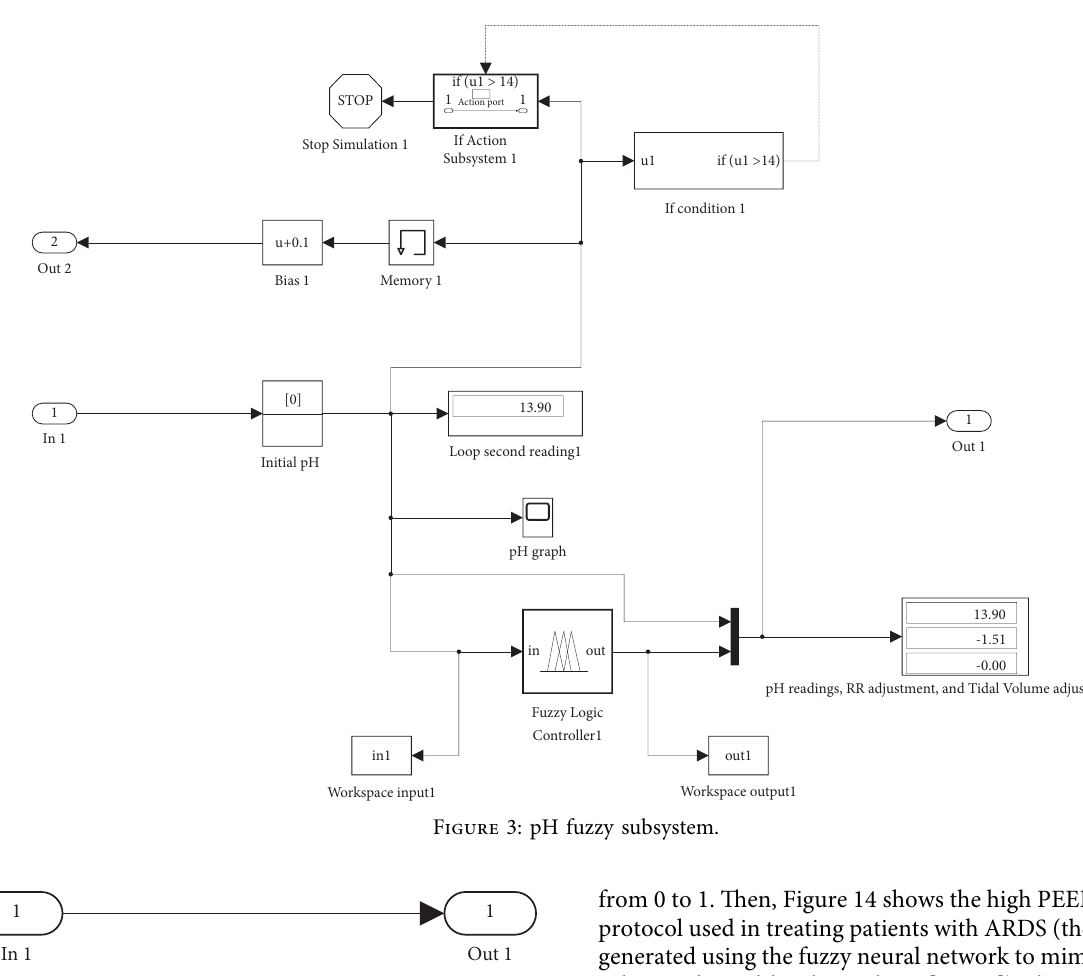
PEEP (ARDSNet protocol recommended high PEEP ad- justments) plots depend on the yellow coloured FiO